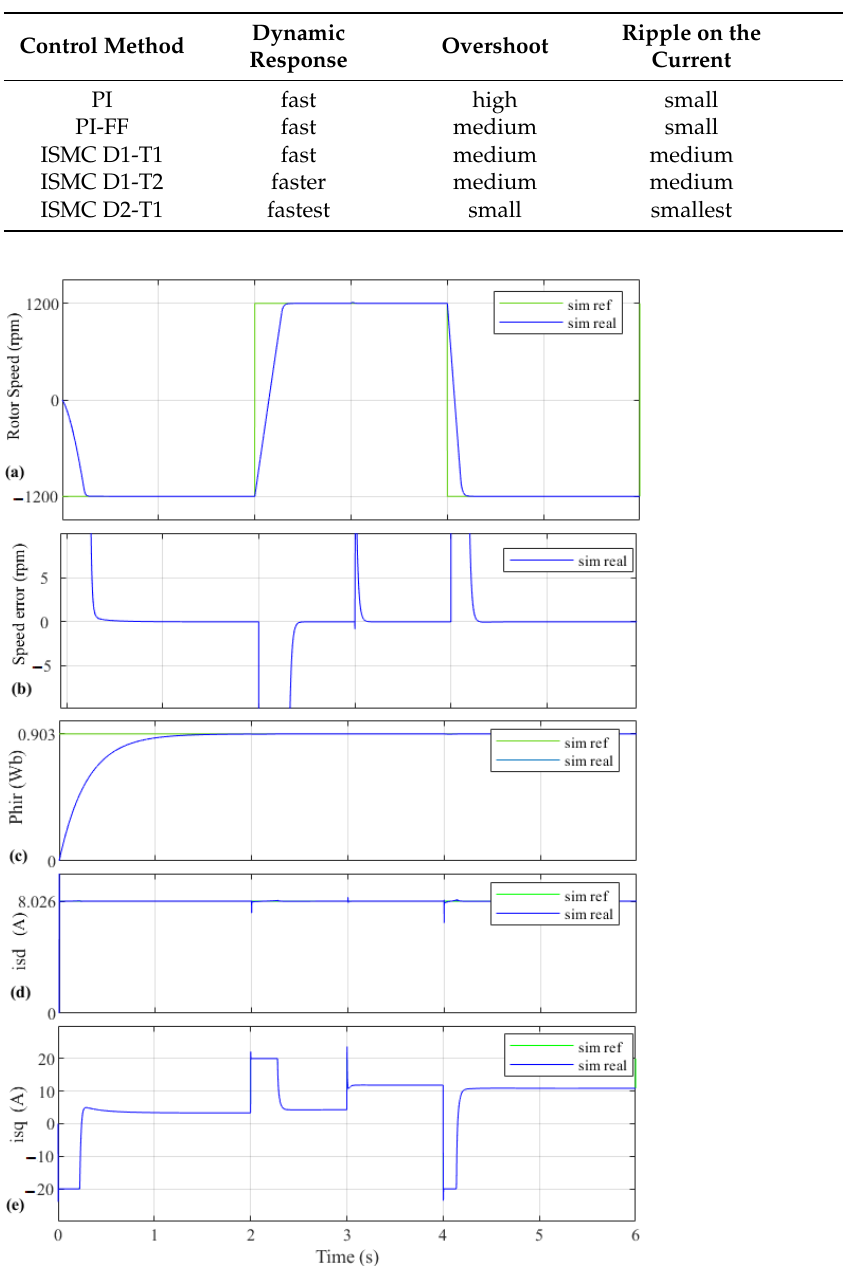
Figure 11. Simulation results with 1200-rpm reference speed and two load torque step changes, with 60% higher uncertainty in σ L s (enhanced ISMC D2 design T3 tuning): ( a ) Rotor speed, ( b ) Speed error, ( c ) Rotor flux, ( d ) Rotor flux current and ( e ) Torque